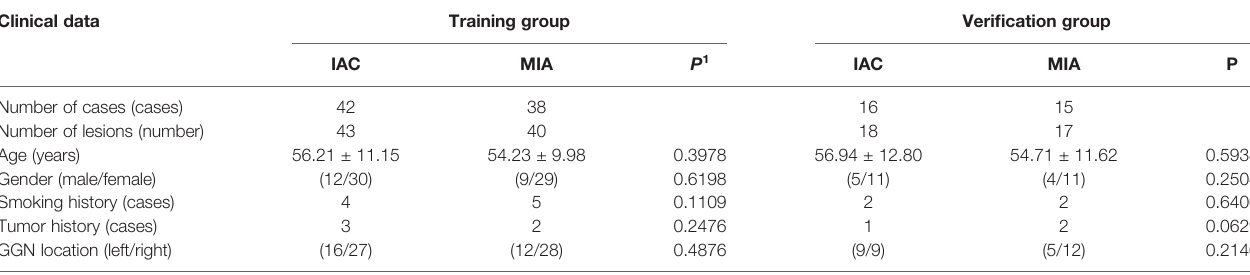
P<0.05 indicates statistically signi fi cant difference. GGN, ground-glass nodule; IAC, invasive adenocarcinoma; MIA, minimally invasive adenocarcinoma.